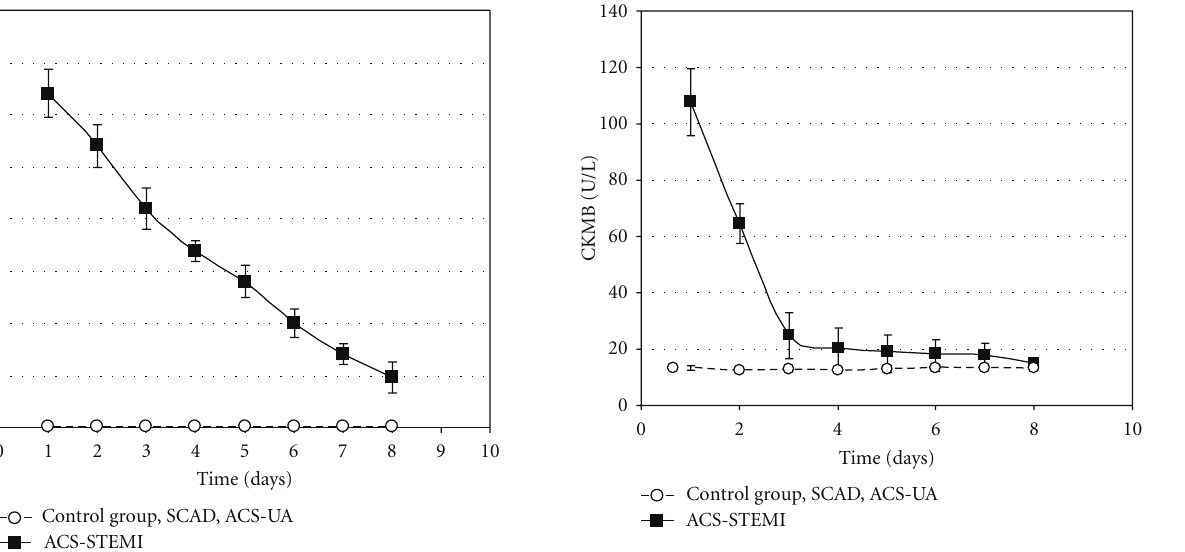
Figure 3: CKMB blood concentration (UL − 1 ) in control group ( n = 32), stable coronary artery disease patients (SCAD, n = 28), acute coronary syndrome, nonocclusive type, patients (ACS- UA, n = 26), and acute coronary syndrome, occlusive type, patients (ACS-STEMI, n = 37) during the eight-day period of testing. CKMB blood concentrations in control, SCAD, and ACS-UA groups were in normal physiological range during the whole investigated period (between 0 and 25 UL − 1 ). The data are presented by means ±